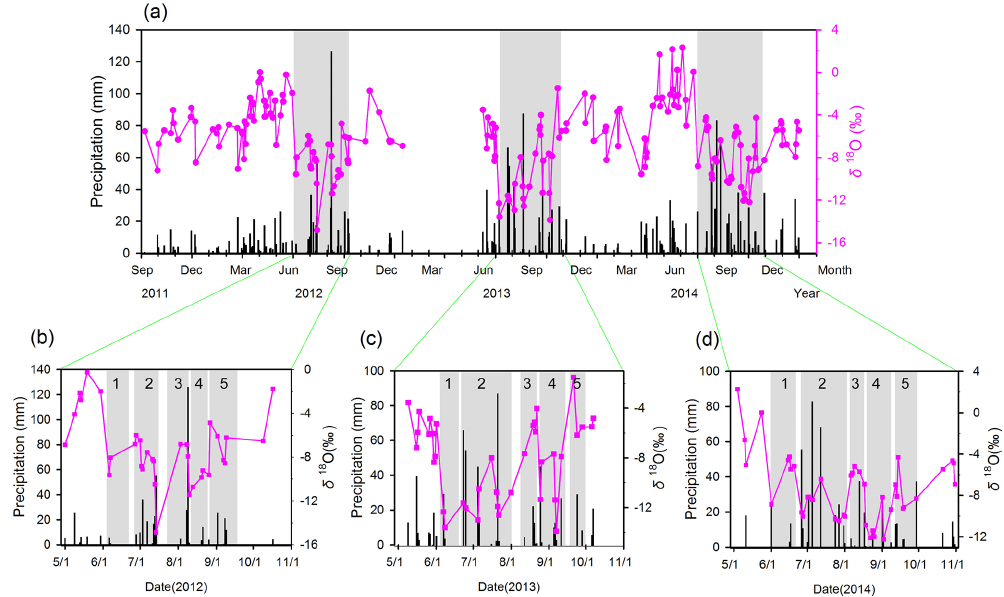
Figure 4. (a) Temporal variation of daily precipitation δ 18 O and precipitation amount from September 2011 to November 2014 (data is missing for δ 18 O from January to April 2013). (b–d) Temporal variations in daily precipitation δ 18 O and local precipitation amount from May to October in 2012 (b) , 2013 (c) , and 2014 (d) . The shaded bars represent different stages. In (b) for 2012, stage 1: 3–20 June; stage